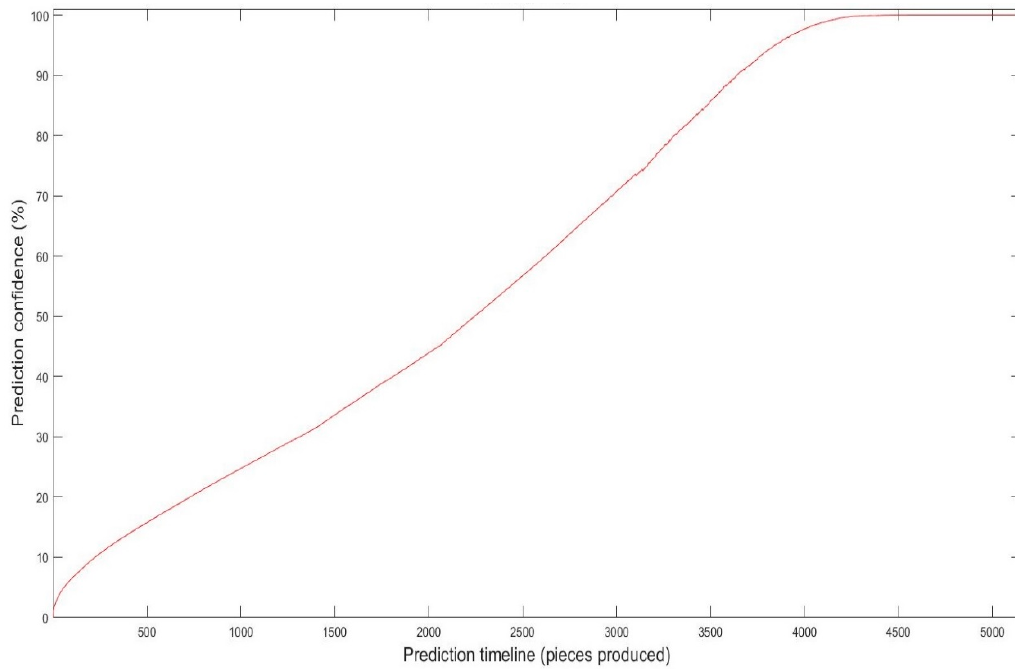
Figure 9. Indicative confidence increase curve during a prediction simulation session.